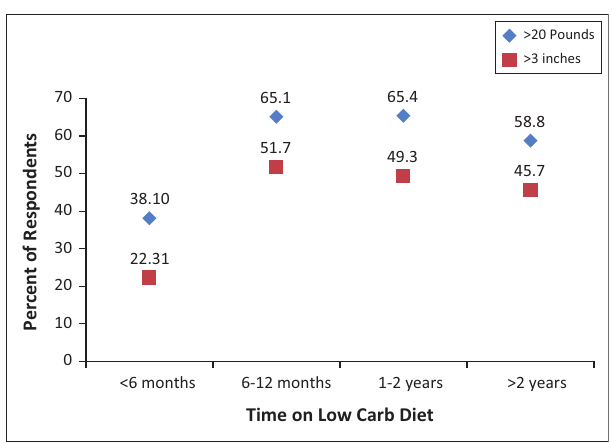
FIGURE 2: Weight and waist circumference loss in relation to time on a low- carbohydrate diet.